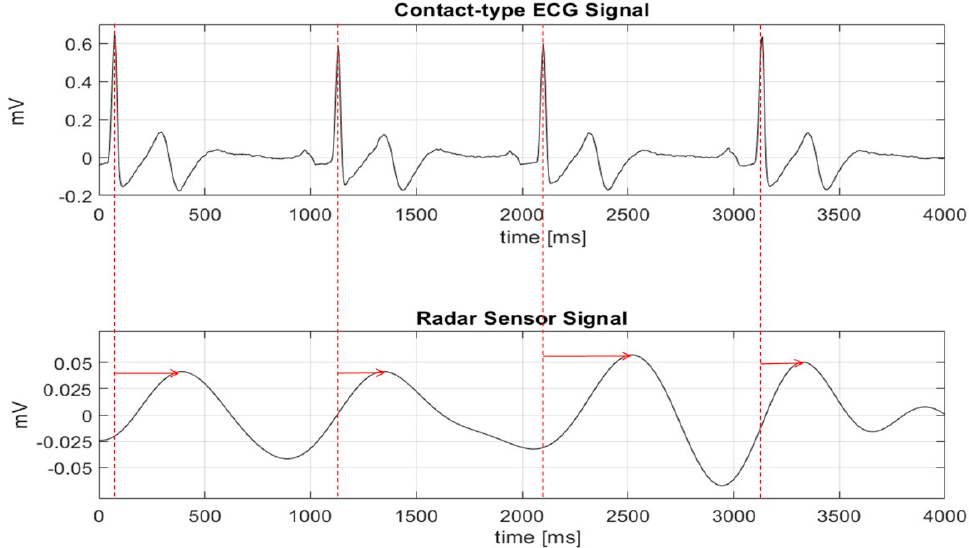
Figure 1. Cardiac-related radar sensor signal and ECG signal comparison in the time domain.